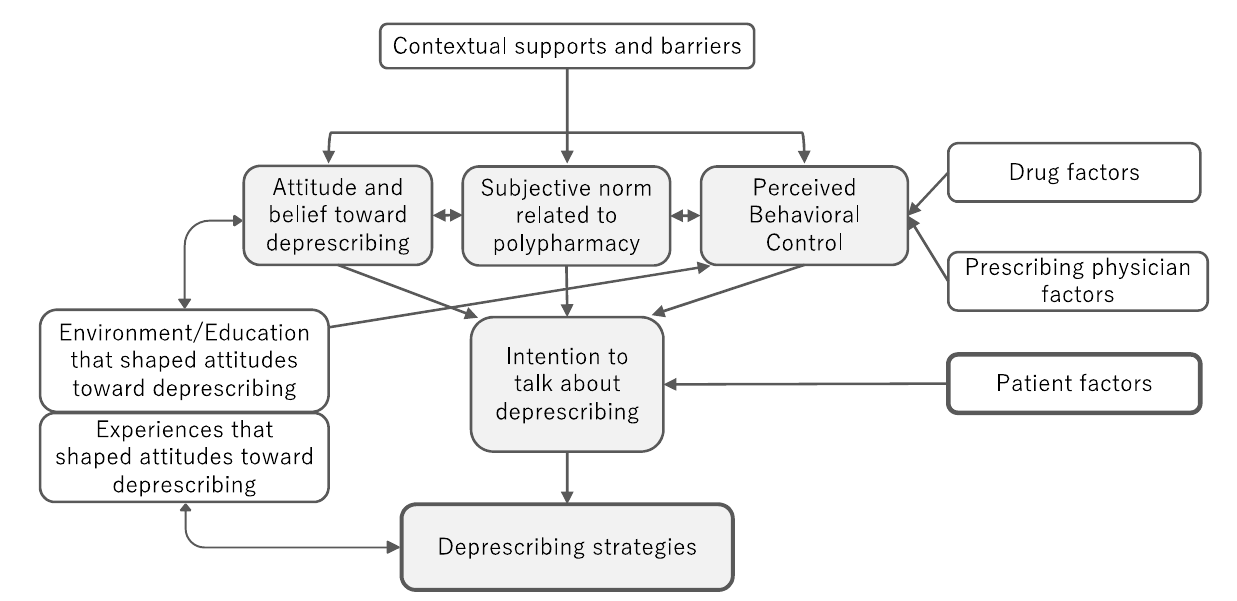
Figure 1. The metacognitive process of deprescribing and influencing factors among general practi- tioners and pharmacists.